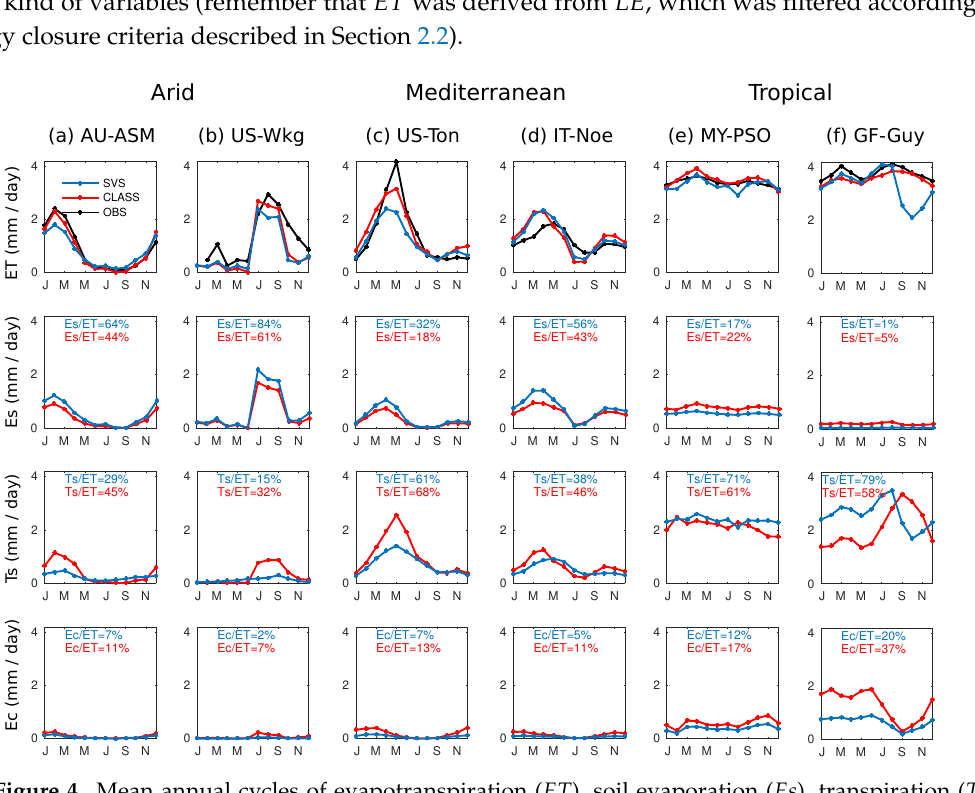
Figure 4. Mean annual cycles of evapotranspiration ( ET ), soil evaporation ( Es ), transpiration ( Ts ) and wet canopy evaporation ( Ec ) at arid sites (( a ) AU-ASM, ( b ) US-Wkg), mediterranean sites (( c ) US-Ton, ( d ) IT-Noe) and tropical sites (( e ) MY-PSO, ( f ) GF-Guy). Black lines correspond to observations, blue and red lines correspond to SVS and CLASS simulations,